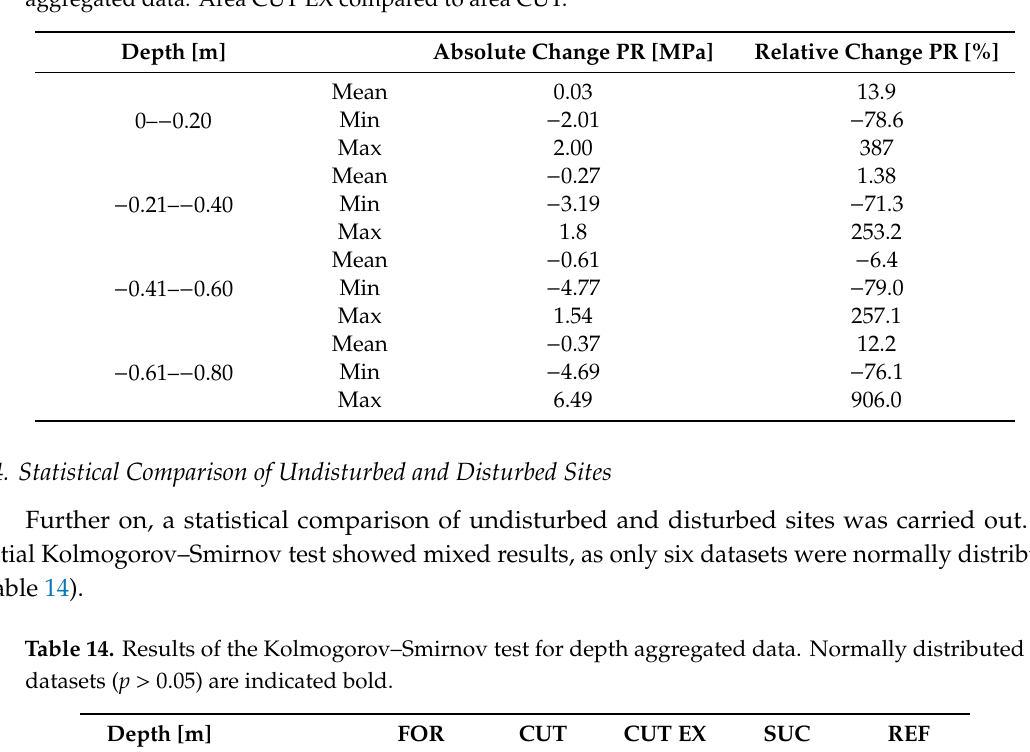
Figure 16. Absolute and relative change of penetration resistance, CUT EX compared to CUT. Table 13. Descriptive statistics for absolute and relative change of penetration resistance (PR), depth aggregated data. Area CUT EX compared to area CUT.